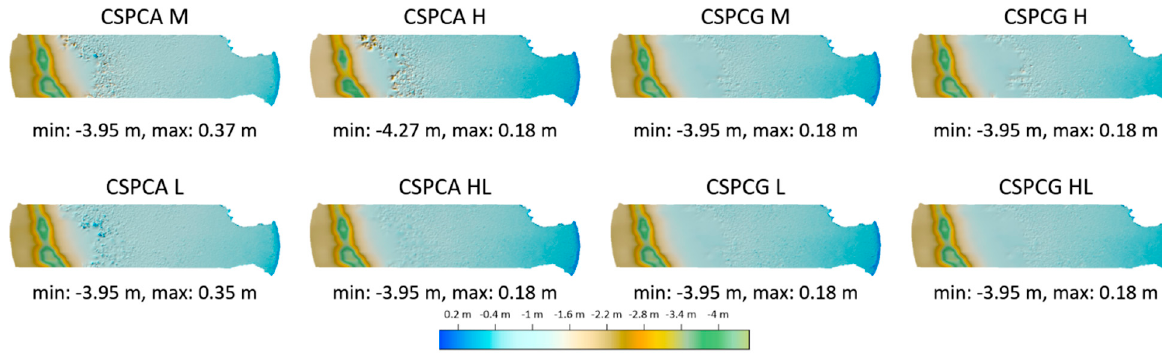
Figure 22. Models obtained by kriging.